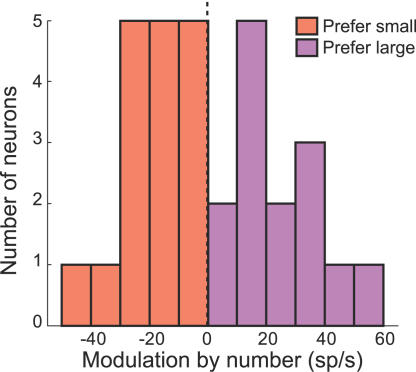
Sensitivity of the LIP Neuronal Population to the Total Number of Elements within the Response FieldFor each neuron, the Δ firing rate across range of numerosities was estimated by linear regression with the logarithmic transform of number (Materials and Methods, Equation 2). Red: neurons with significant negative slope (prefer small numerosity); purple: neurons with significant positive slope (prefer large numerosity).